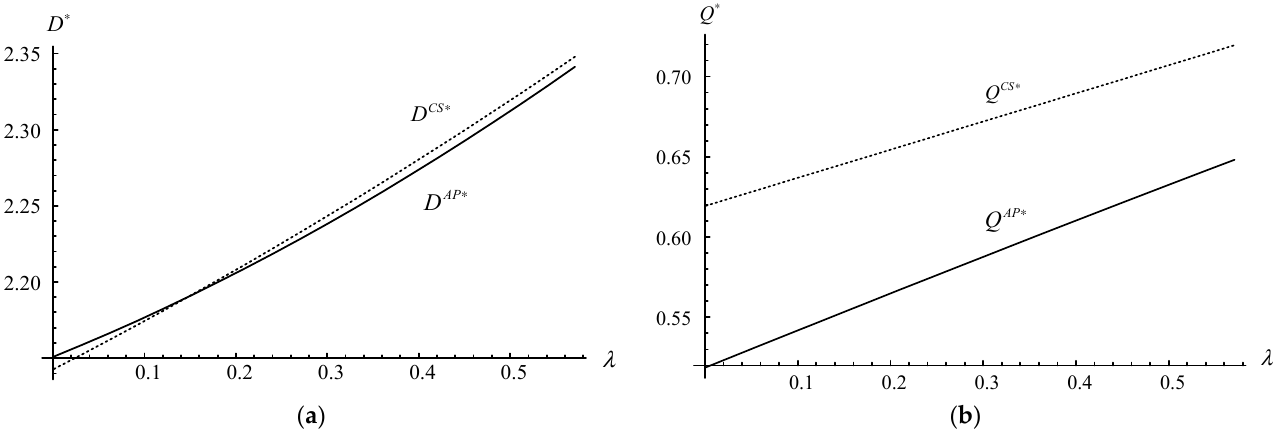
Figure 4. Demand/Recycling quantities vs. the disassembly rate. ( a ) Demand vs. the disassembly rate. ( b ) Recycling quantities vs. the disassembly rate.